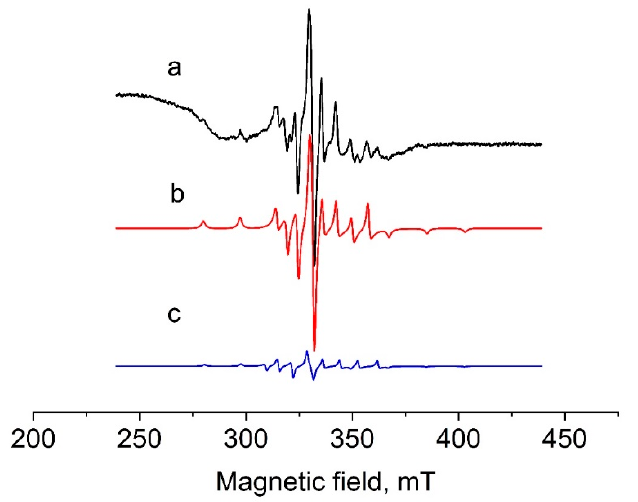
Figure 1. EPR spectra of solution of 1 in dichloromethane at 77 K. Black—experimental, red and blue—simulated.